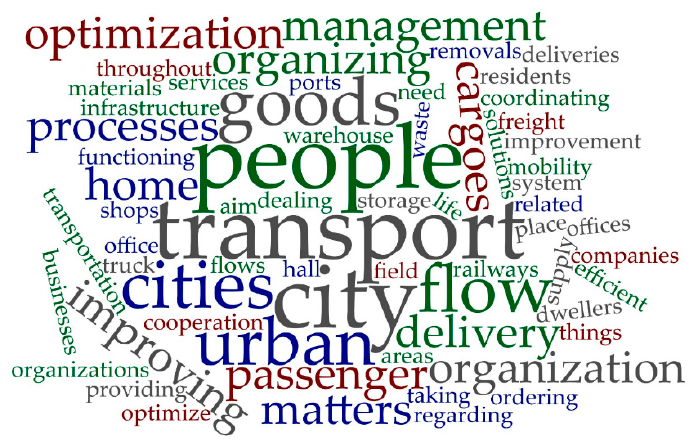
Figure 2. Word cloud for answers to Q1.